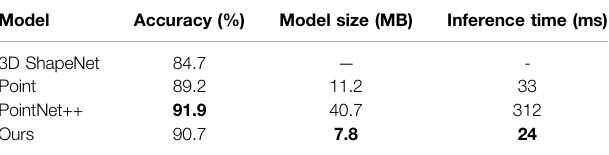
TABLE 1 | Results comparison on